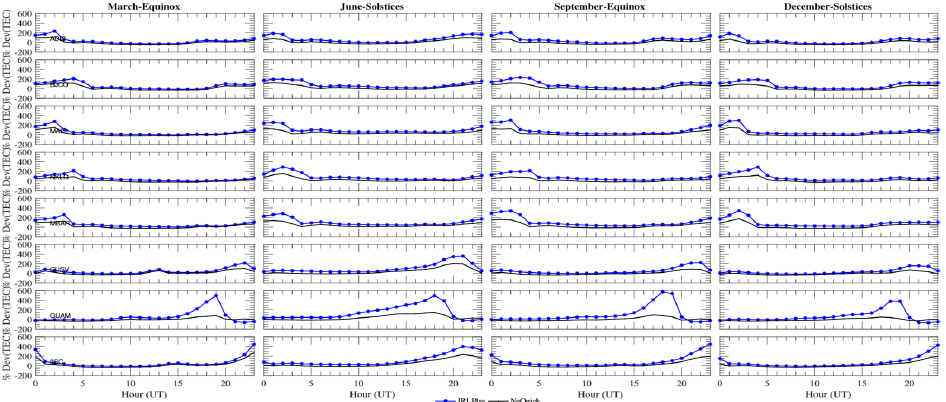
Figure 6. Averaged seasonal Percentage Deviation of IRI-PLAS and NeQuick model for the entire stations considered in the year 2014.